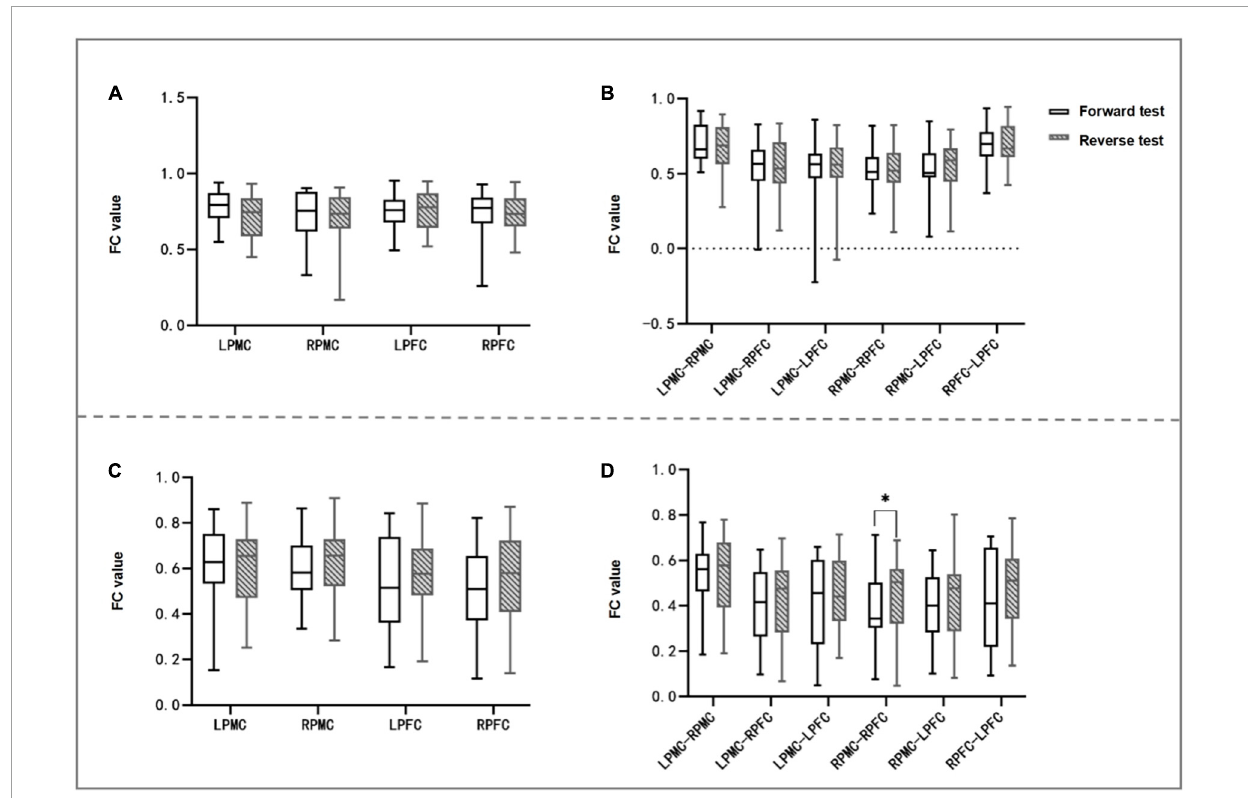
FIGURE5 Intra-group comparison of FC of homologous and heterologous ROI of two groups of subjects. (A,B) Are young groups, panel (A) is the intra-group comparison of FC values of forward and reverse judgment tests of homologous ROI, and panel (B) is the intra-group comparison of heterologous ROI; (C,D) are the elderly group, panel (C) is the intra-group comparison of homologous ROI, and panel (D) is the intra-group comparison of heterologous ROI; panel (D) shows that the FC value of RPMC-RPFC is statistically different between the forward and reverse judgment test ( P < 0.05). FC, functional connection; LPFC, left prefrontal cortex; RPFC, right prefrontal cortex; LPMC, left primary motor cortex; RPMC, right primary motor cortex; ROI, region of interest; ∗ P <